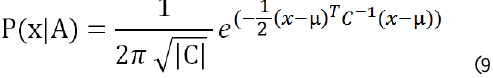
Table 11. Error Matrix of the 3rd test case (FW LiDAR and